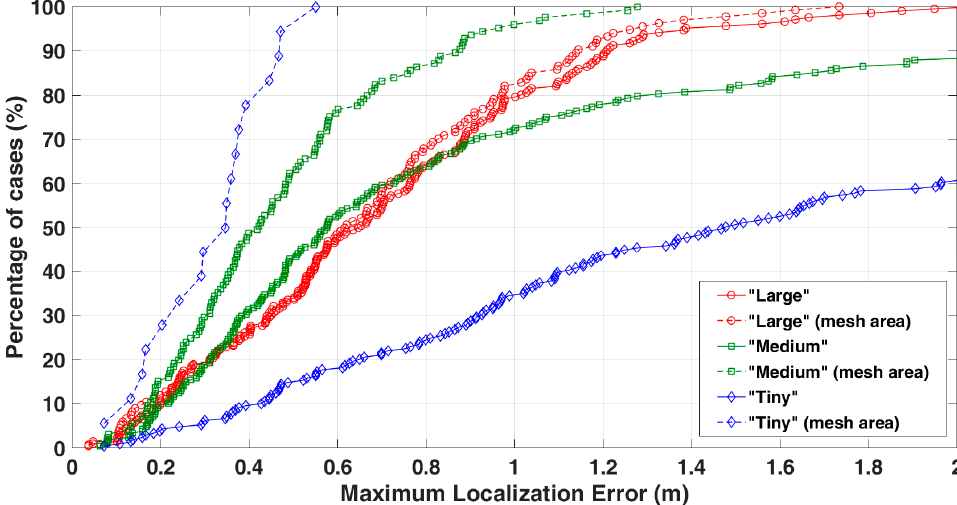
Figure 12. Measured localization error CDFs, for the three cases of study. Data acquired at the 299 points in the room of Figure 9a, assuming the mobile tag pointing upward, 5 averaged RSSI data for point and each antenna element, mobile tag height = 1.1 m.